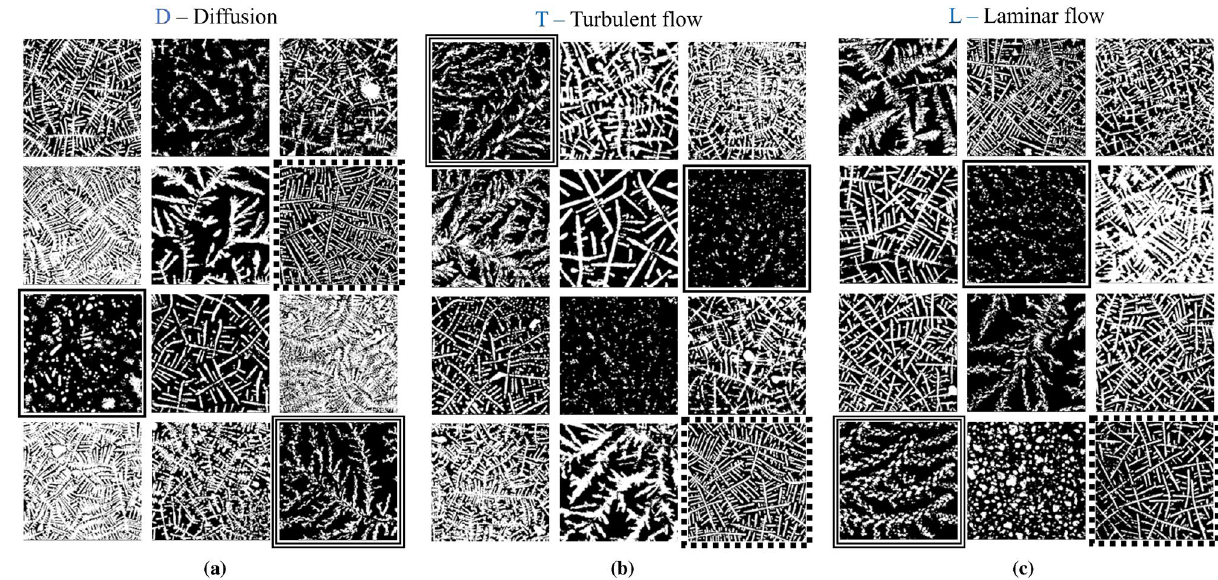
Figure 2. Texture diversity in some selected patches from different mixing procedures. The highlighted patches with dashed, solid and double frames from mixing procedure D share (visually) similar textures with the corresponding highlighted patches from mixing procedures T and L. ( a ) Patches from the D—diffusion control variant. ( b ) Patches from variant T—turbulent flow. ( c ) Patches from variant L—laminar